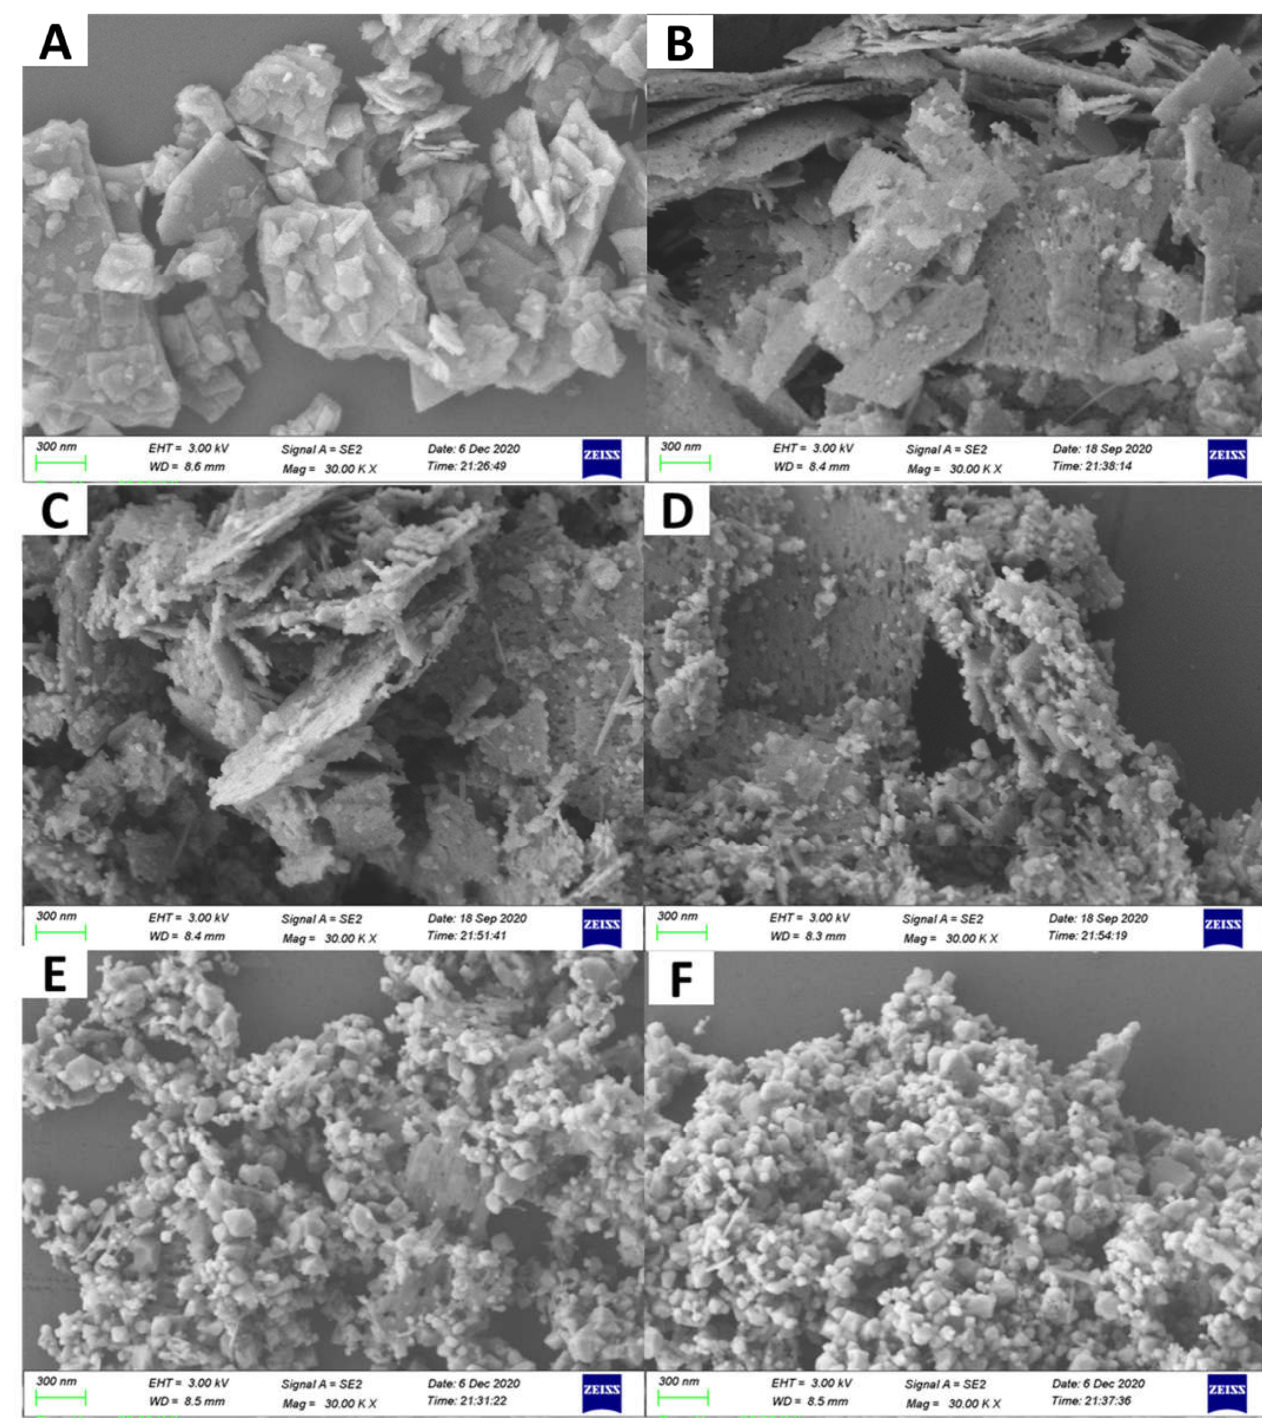
Figure 3. SEM images of the as-prepared samples, ( A ) ZnS, ( B ) ZnS/ZnO-10 min, ( C ) ZnS/ZnO-0.5 h, ( D ) ZnS/ZnO-1 h, ( E ) ZnS/ZnO-3 h, ( F ) ZnO.